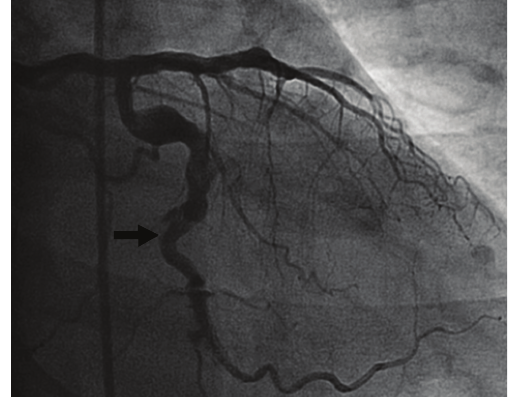
Figure 2: Angiogram six months prior reveals a mildly ectatic but not aneurysmatic left circumflex coronary artery (arrow).